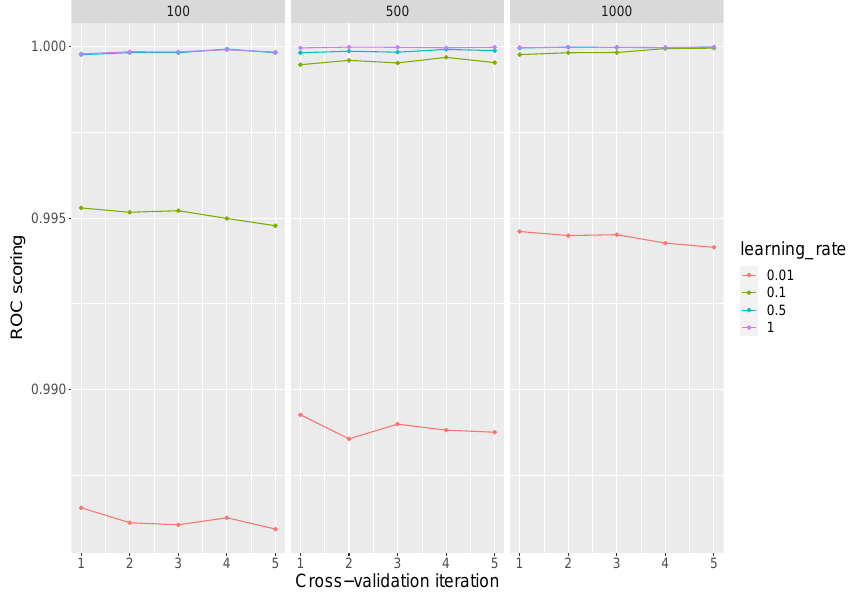
Figure 5. Adaboost mean scoring by iteration.